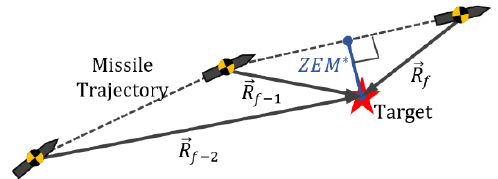
Figure 2. Diagram of Zero-Effort-Miss (ZEM)* definition.